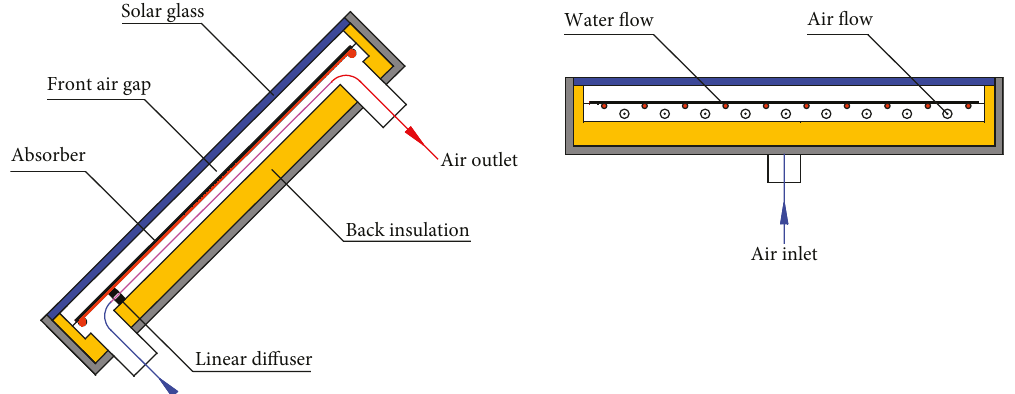
Figure 4: Design of the prototype of DAWC.